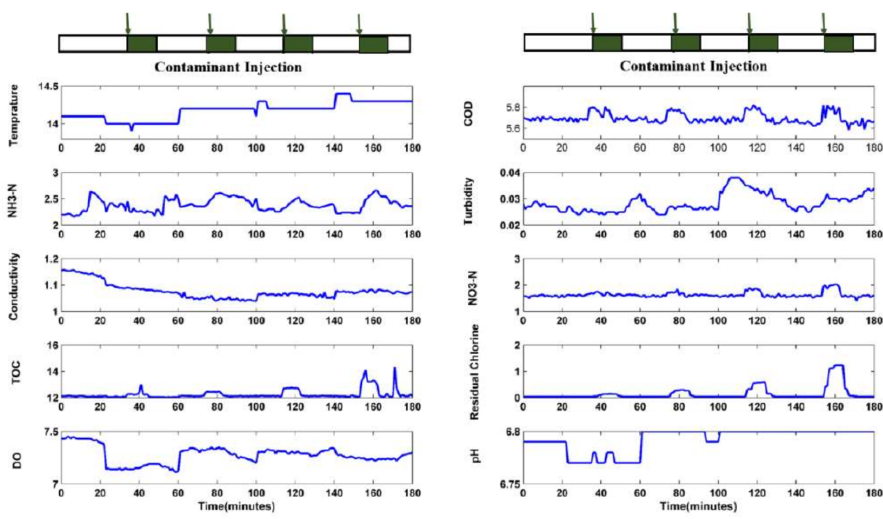
Figure 4. Sensor responses for potassium ferricyanide (concentrations: 1.0, 2.0, 4.0, and 8.0 mg L − 1